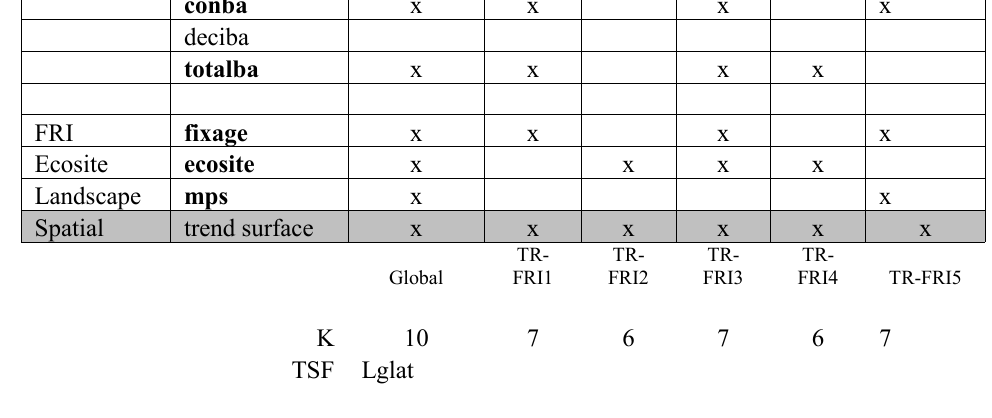
Least Flycatcher (LEFL)